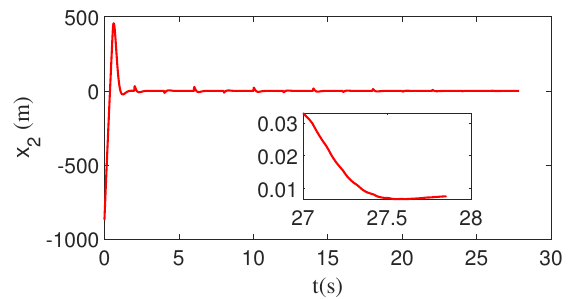
Figure 13. The change in ZEM with square wave